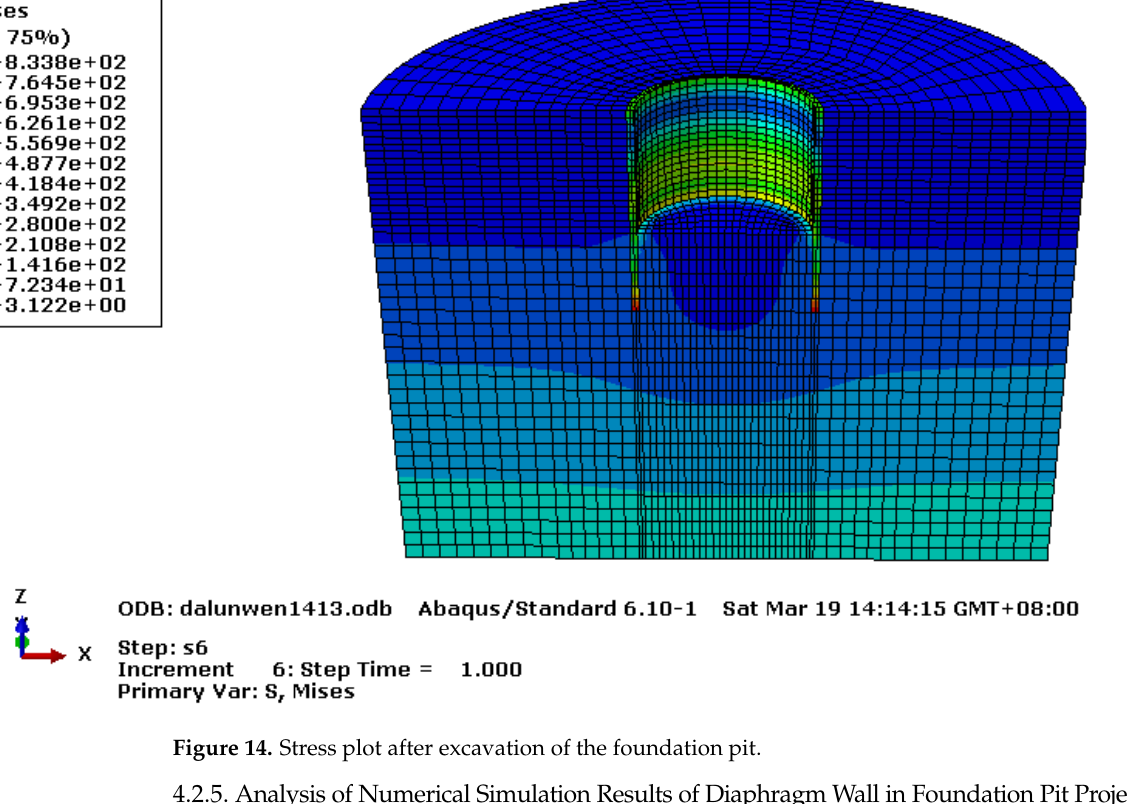
Figure 14. Stress plot after excavation of the foundation pit.